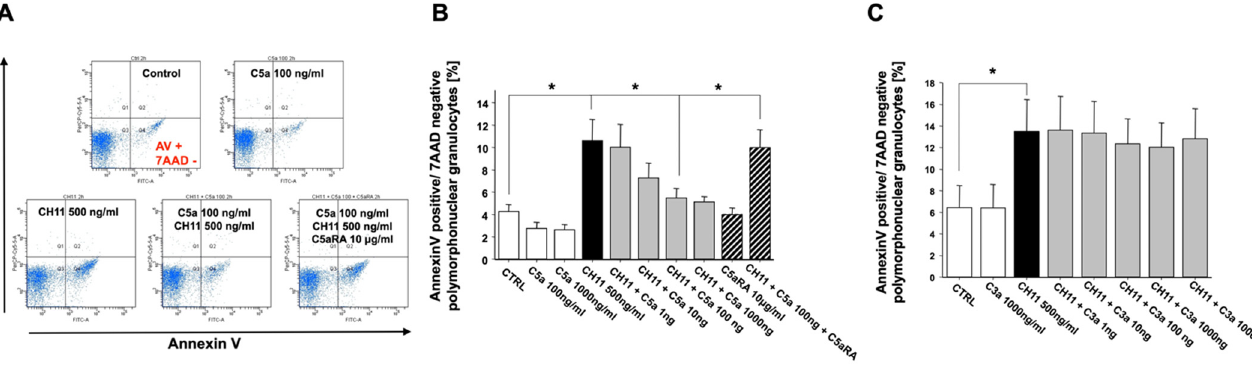
Figure 4. C5a ( n = 4) ( A ) but not C3a ( n = 3) ( B ) inhibits the intrinsic, H 2 O 2 -induced apoptosis rate of freshly isolated PMN from healthy male volunteers in a concentration-dependent manner. The percentage of apoptotic PMN was determined by Annexin-V/7-AAD staining and flow cytometry. C5aRA = C5aR1 specific small peptide inhibitor PMX53. Results are shown as mean ± SEM. * = p < 0.05.